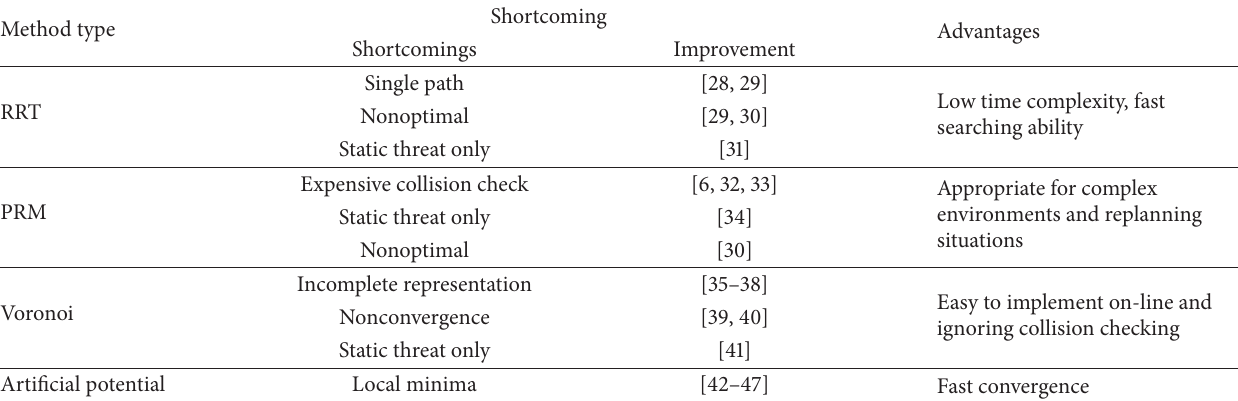
Table 2: Analysis of sampling based algorithms.